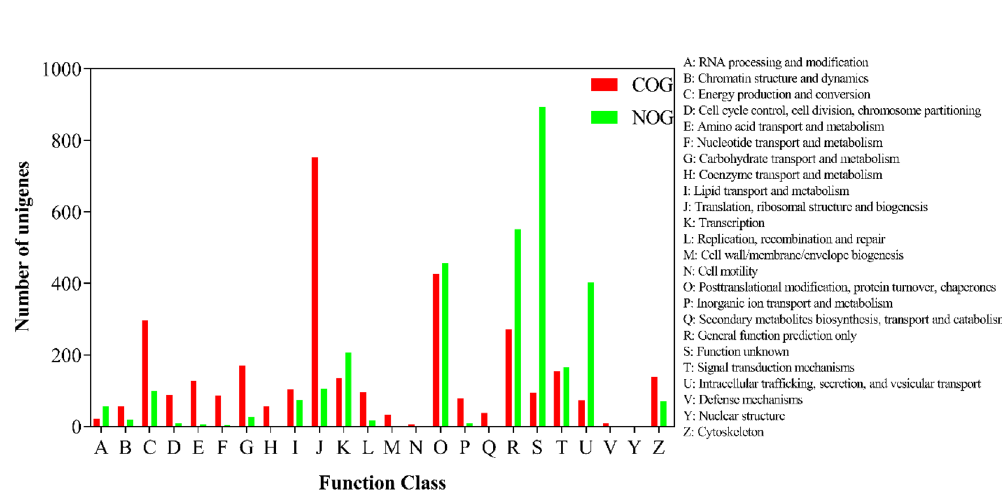
Figure 3. COG/NOG functional annotation of adult spongy moth